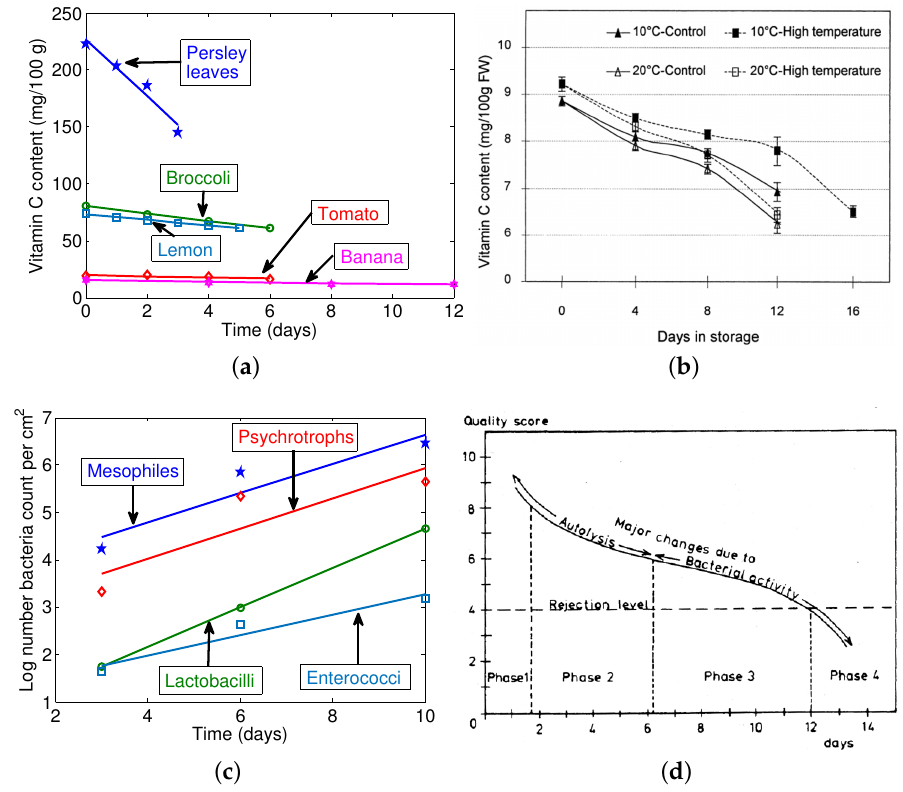
Figure 4. ( a ) Vitamin C degradation in different vegetables at 20 ◦ C (data obtained from [15]). ( b ) Changes in vitamin C content of cucumbers grown at control or high temperatures during their storage at 10 or 20 ◦ C [16]. ( c ) Bacterial content in chicken meat at 2 ◦ C (data obtained from [17]). ( d ) Changes in sensory quality of iced cod (0 ◦ C)